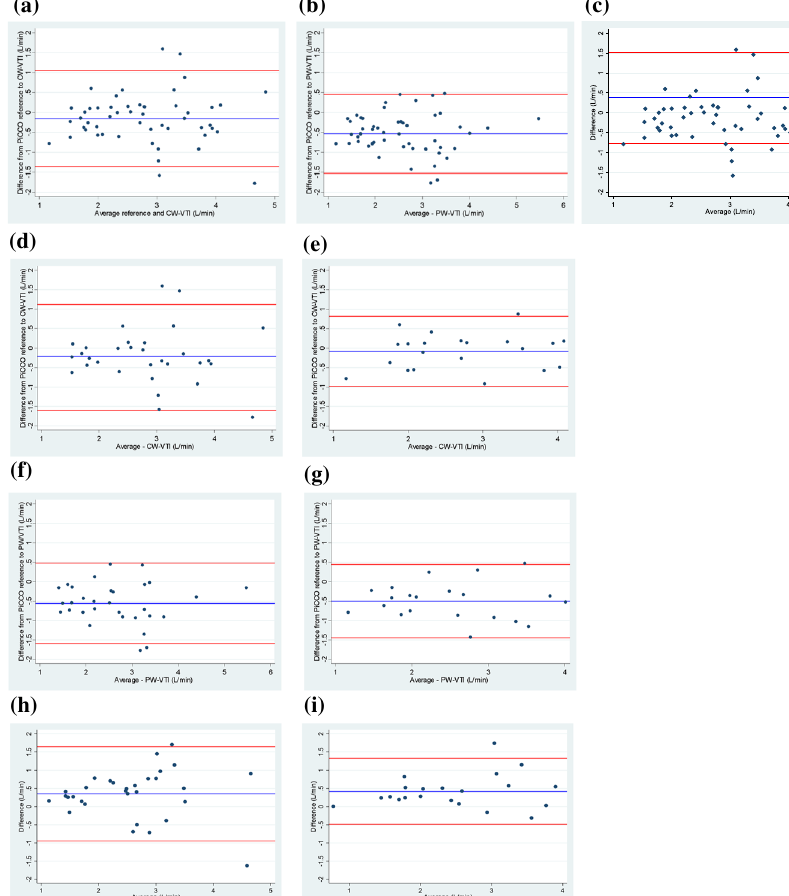
Fig. 1 Panel figure of Bland–Altman plots. A Bland–Altman plot for CW‑VTI measurement relative to PiCCO reference; B Bland–Altman plot for PW‑VTI measurement relative to PiCCO reference; C Bland–Altman plot for CW‑VTI measurement relative to PW‑VTI measurement. (Continuous‑wave Velocity Time integral CW‑VTI; = Pulsed‑wave Velocity Time integral CW‑VTI; Pulse Contour Cardiac Output PiCCO); D Bland‑Altman plot = = for CW‑VTI measurement relative to PiCCO reference–Measurements less than 15 min only; E Bland‑Altman plot for LVOT measurement relative to PiCCO reference–Measurements less than 15 min only; F Bland‑Altman plot for CW‑VTI measurement relative to PW‑VTI measurement–Measurements less than 15 min only; G Bland‑Altman plot for CW‑VTI measurement relative to PiCCO reference–Measurements greater than 15 min only; H Bland‑Altman plot for PW‑VTI measurement relative to PiCCO reference–Measurements greater than 15 min only; I Bland‑Altman plot for CW‑VTI measurement relative to PW‑VTI measurement–Measurements greater than 15 min